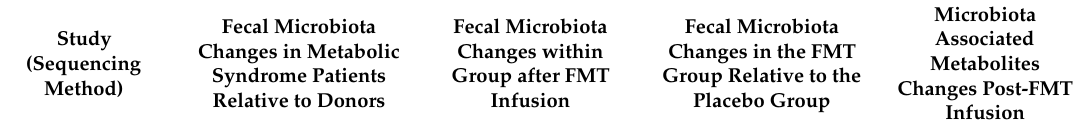
Table 4. E ff ects of FMT on the gut microbiome composition and associated